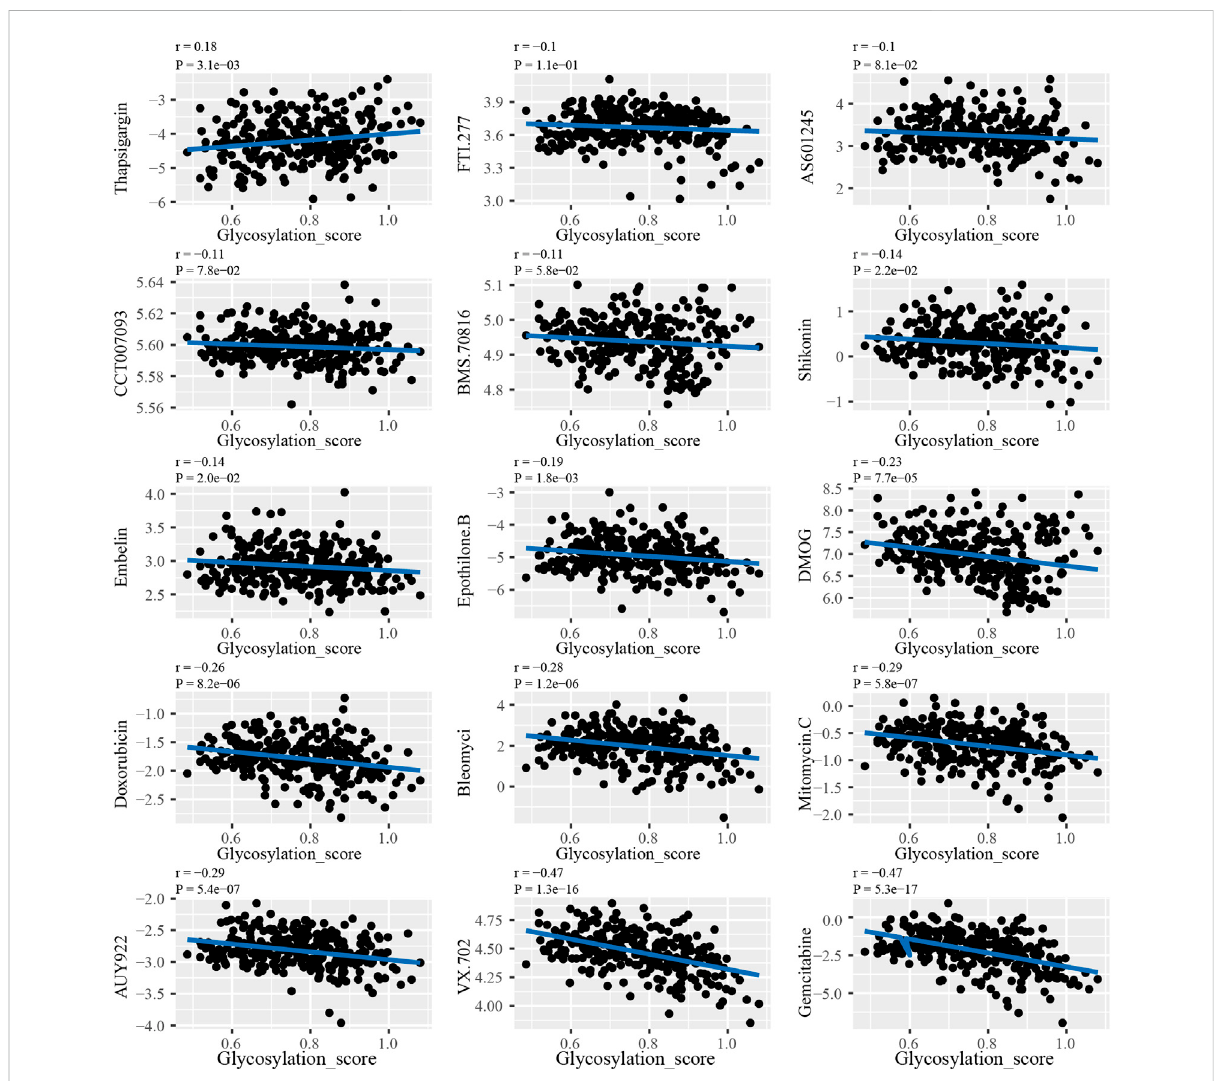
FIGURE 7 The correlation analysis between glycosylation score and drug